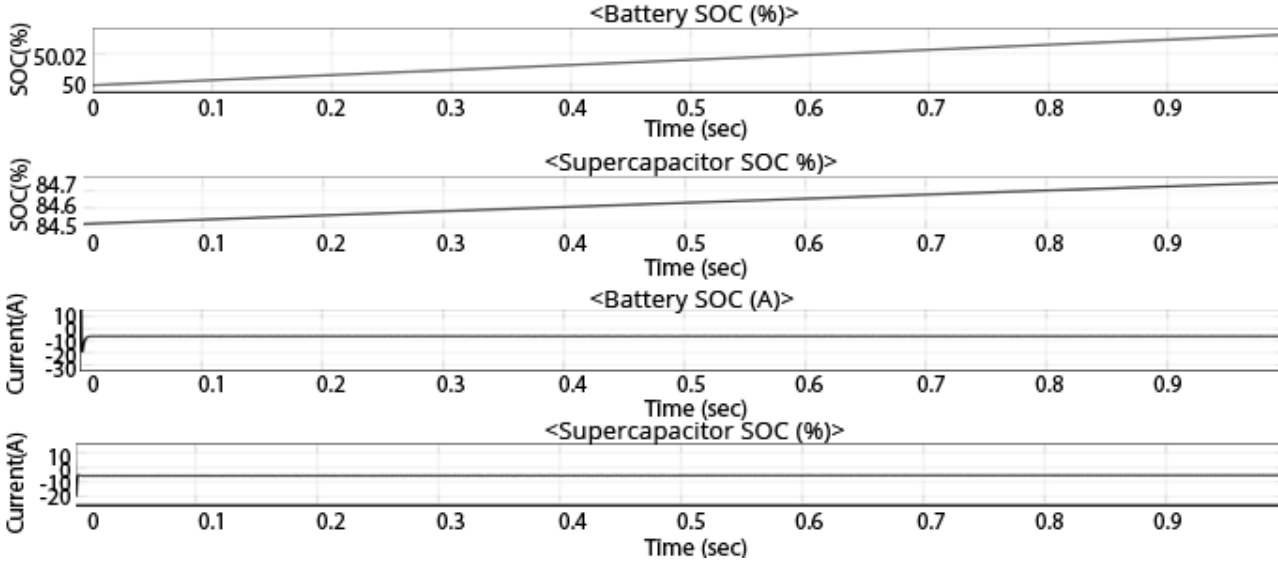
Figure 13. SOC and charging currents of battery and supercapacitor in mode 5.